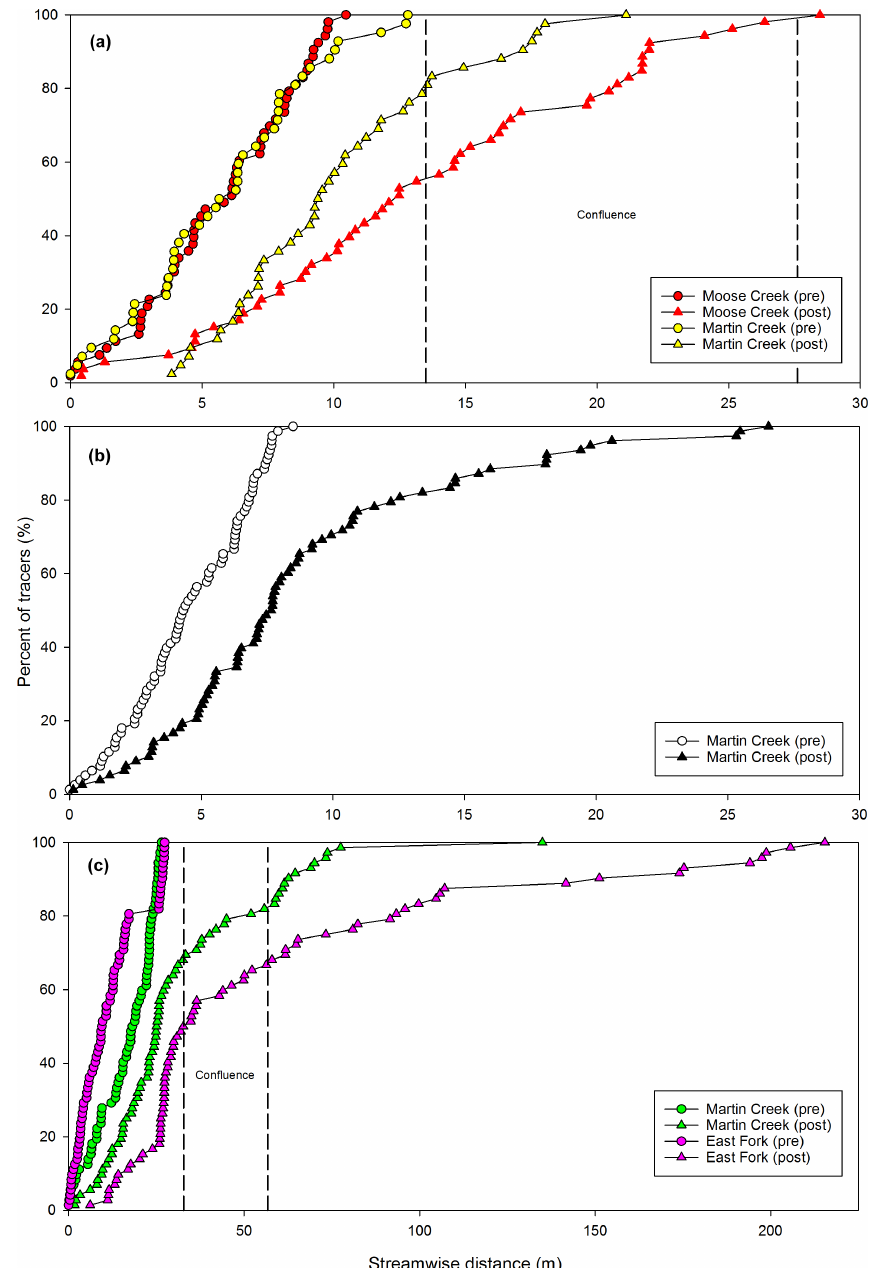
Figure 7. Spatial distribution of tracer positions at the time of initial deployment (pre) and after the 2014 flood (post) for (a) the upper confluence, (b) the control reach, and (c) the lower confluence. The confluence zones are bracketed with dotted vertical lines. Note the altered x axis scale in (c)